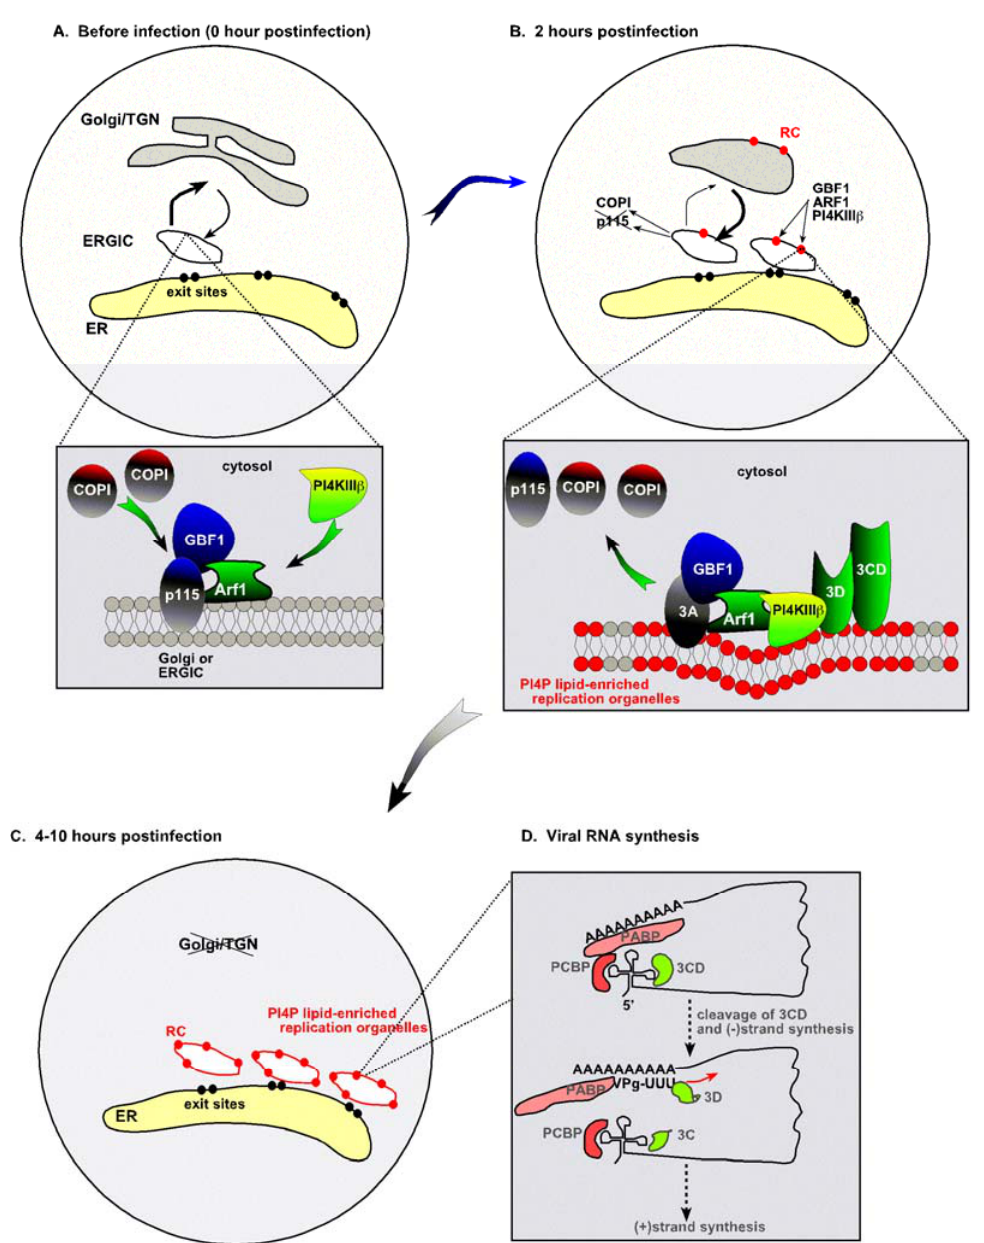
Figure 1. Remodeling the cellular secretory pathway to support enterovirus replication. (A) Trafficking between the ER and the Golgi is shown schematically in uninfected cells. The ER-Golgi intermediate compartment (ERGIC) is decorated with COPI, which is recruited by the small GTPase Arf1 and the guanosine exchange factor GBF1. (B) At the early time point, enteroviruses, such as PV or CVB3, starts replication in Golgi/TGN compartment. The virally-coded 3A tail-anchored membrane protein binds to GBF1 and Arf1 and promotes the redistribution of COPI and p115 membrane protein to the cytosol. These events inhibit the vesicular transport between the ER and Golgi/TGN. (C) At 4-10-hour time points of infection, synthesis of newly made abundant 3A molecules leads to remodeling of the Golgi/TGN and ERGIC compartments into viral organelles. The replication organelles, indicated by red ovals, contain increased amount of PI4P lipids due to the recruitment of PI4KIII  , which makes PI4P, via Arf1 with the help of 3A. The enriched PI4P contents of these the replicase complex (RC) and viral RNA synthesis. The figure was modified from [1]. (D) Factors involved in the RNA synthesis by the PV replicase assembled on the Golgi/TGN